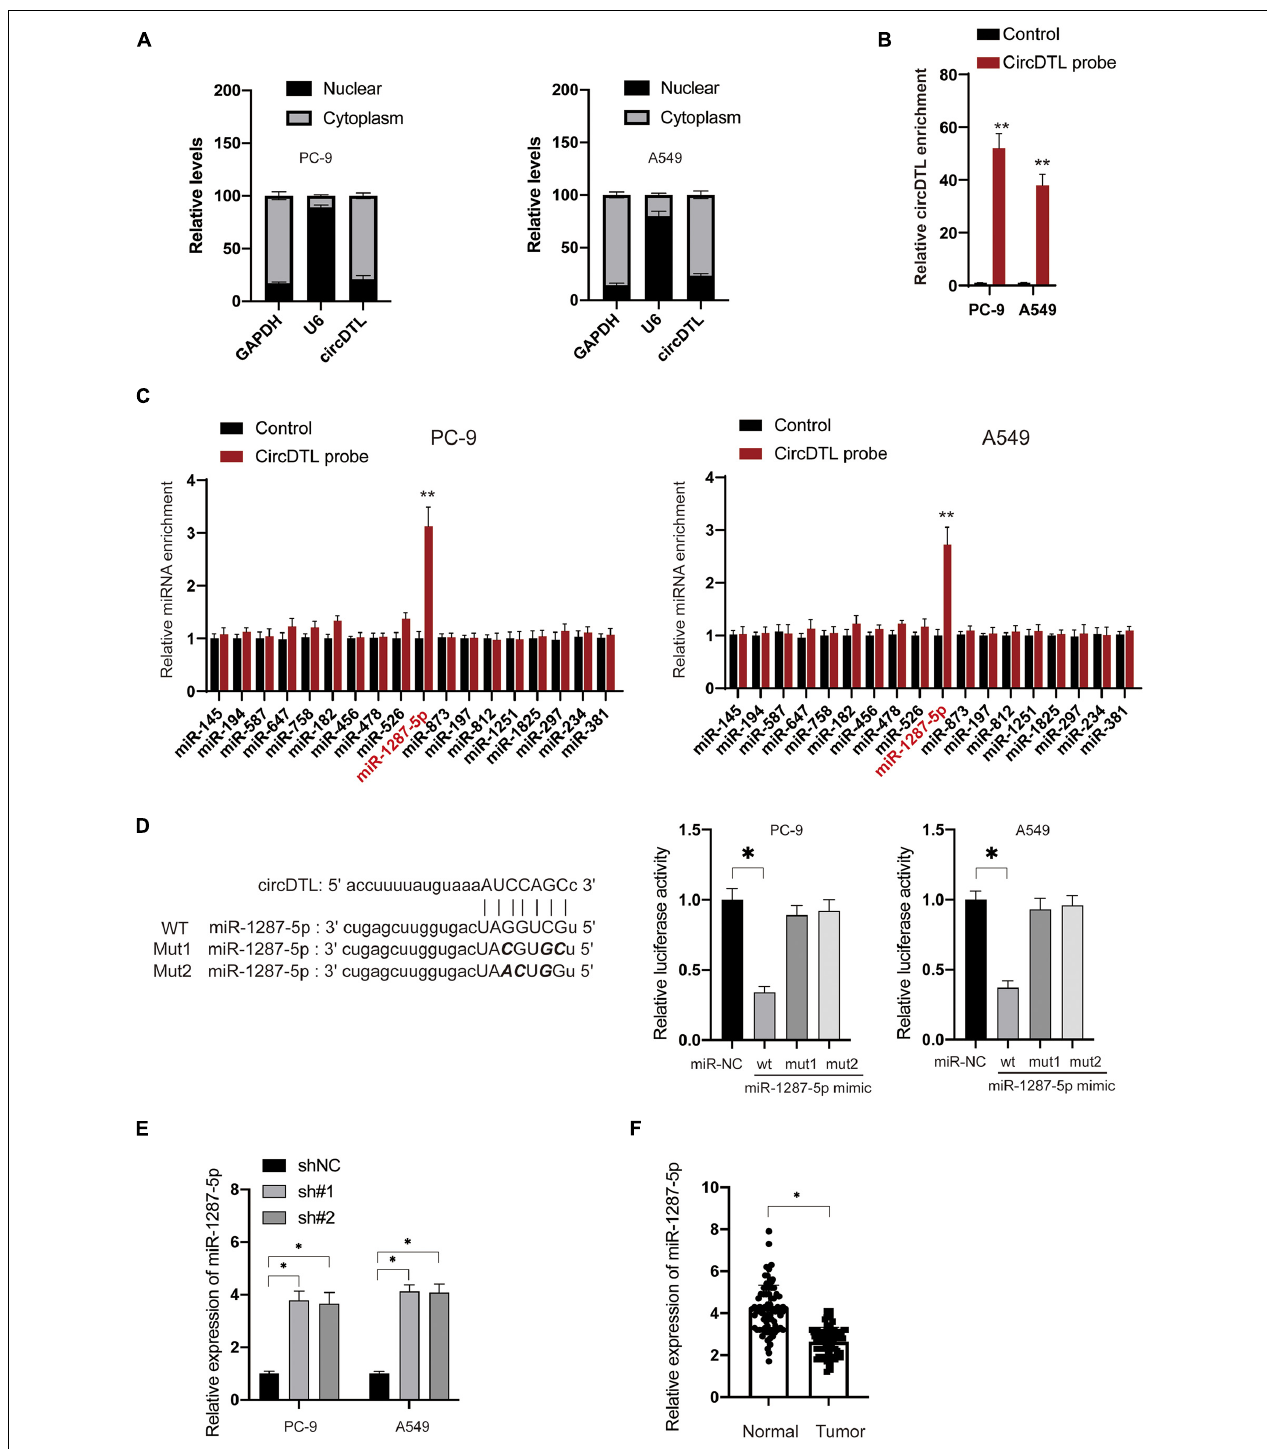
FIGURE 3 | circDTL negatively regulates the expression of miR-1287-5p in NSCLC cells. (A) Cellular location of GAPDH, U6, and circDTL was assayed in NSCLC cells. (B) RNA pull-down assay was used for the detection of circDTL. (C) RNA pull-down was performed to examine different miRNAs that bind with circDTL. (D) Predictive binding sites between circDTL and miR-1287-5p (left), the interaction between miR-1287-5p and circDTL was evaluated by dual-luciferase reporter assay (right). (E) NSCLC cells were transfected with shNC or shRNAs against circDTL (sh#1, sh#2) for 24 h, levels of miR-1287-5p were measured. (F) The expression of miR-1287-5p in 84 pairs of NSCLC and adjacent normal tissues. Data were presented as mean ± SD. Experiments were performed at least three times. ∗ P < 0.05; ∗∗ P < 0.01.